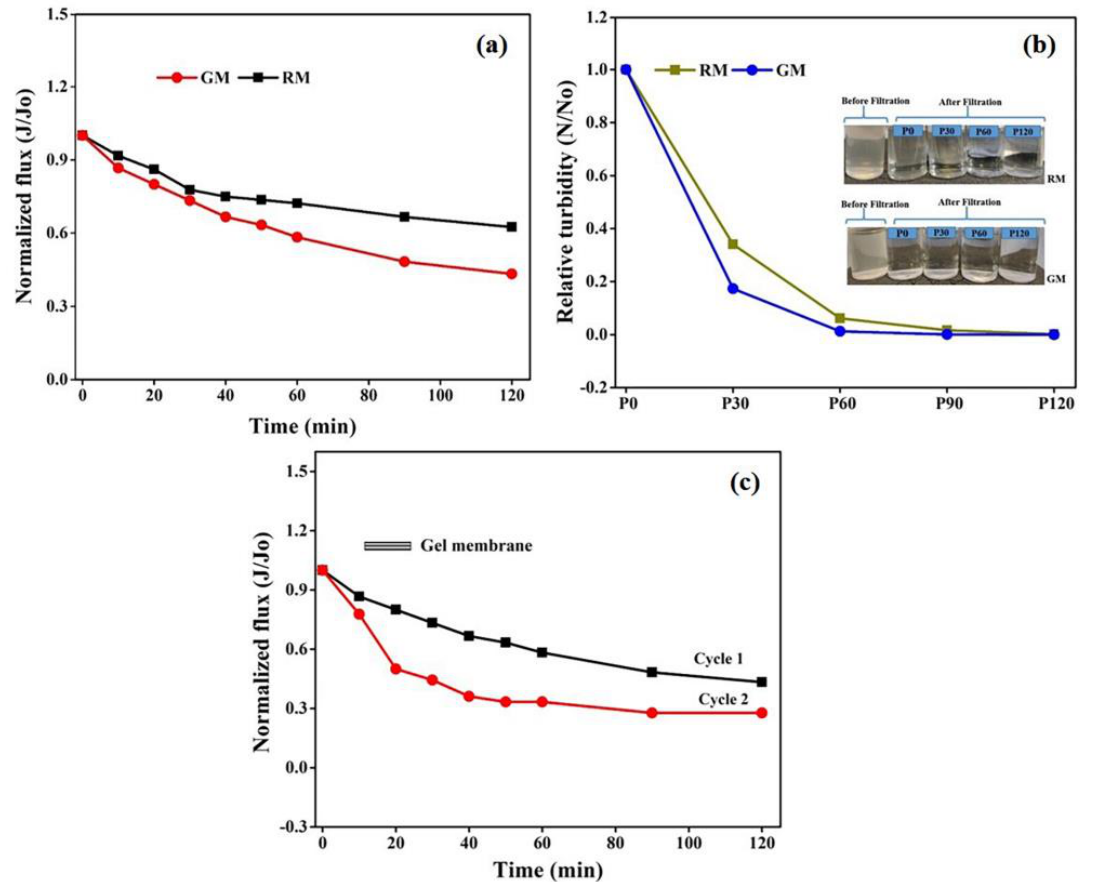
Figure 11. Membrane permeability ( a ) with respect to wastewater, ( b ) turbidity analyses of permeate stream over time and ( c ) relative flux of the gel membrane after two run cycles.